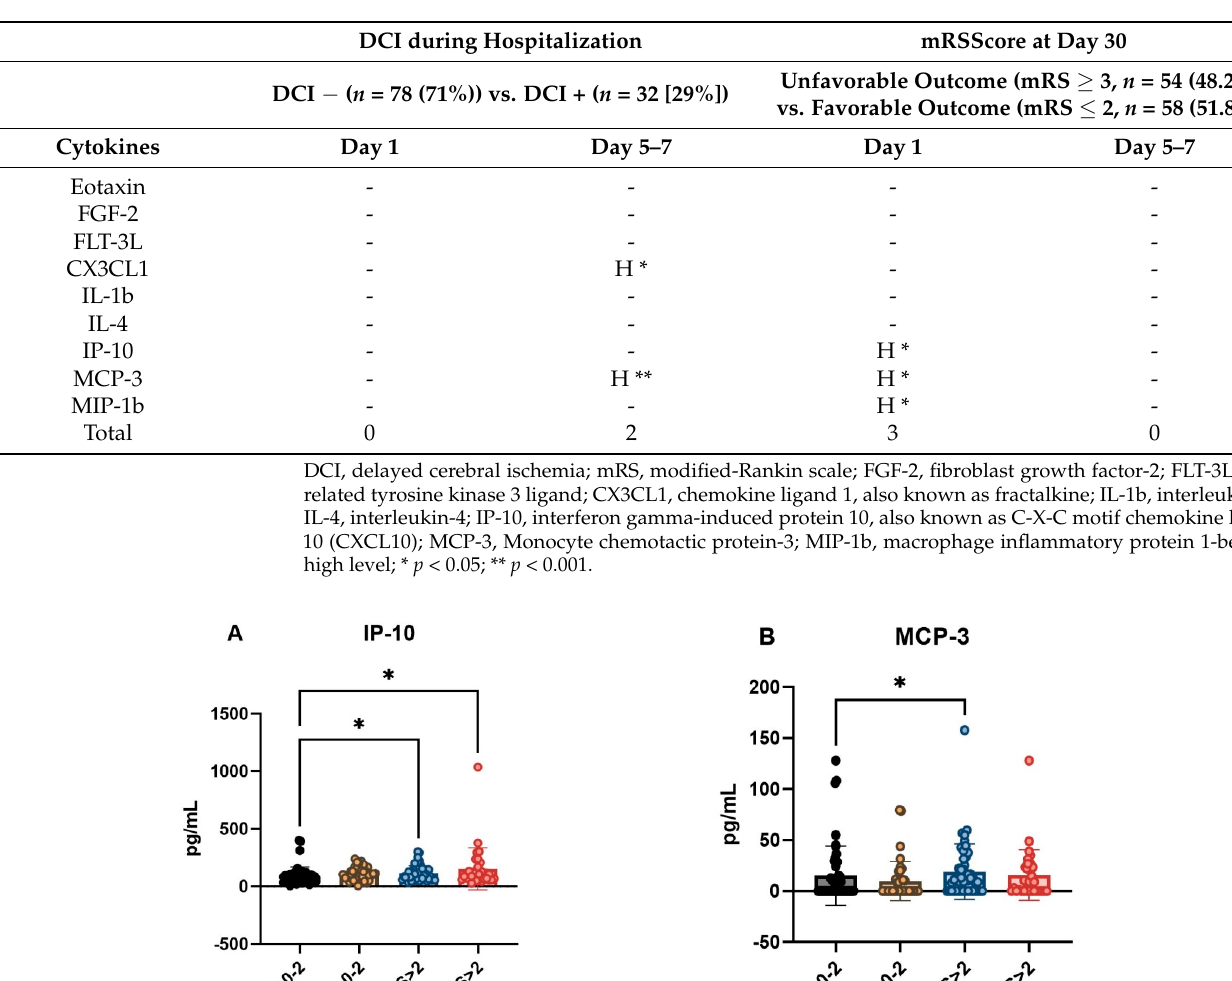
Table 2. Cytokines associated with DCI during hospitalization and functional outcome on Day 30.